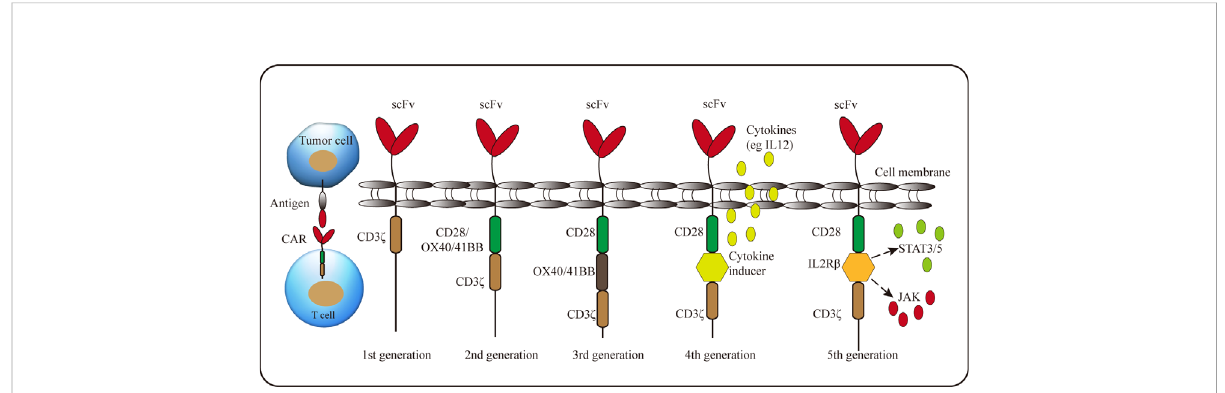
FIGURE 2 Schematic representation of the CAR structure. A CAR consists of single-chain variable fragment with a hinge, transmembrane domain, and CD3 z (1st generation). 2nd generation and 3rd generation CARs contain one or two costimulatory molecules, respectively. Whereas the signal domain of the 4th generation CAR includes an inducible cytokine cassette. The 5th generation CAR encodes a truncated cytoplasmic domain of IL-2 receptor b with a binding site for the STAT3 to activate JAK-STAT